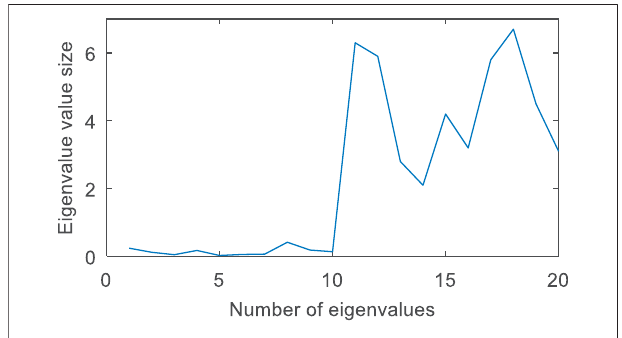
FIGURE 8 | Results of the difference method between current cycles.